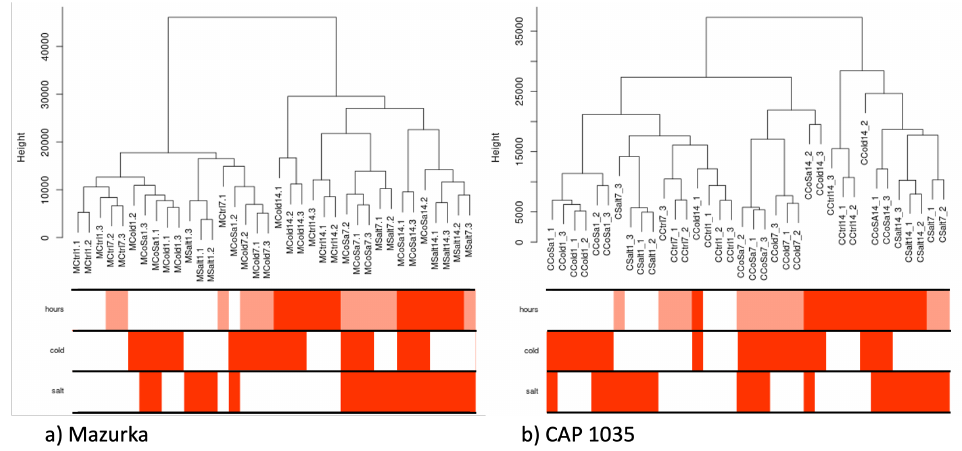
Figure A3. Dendrogram of trait cluster for Mazurka ( a ) and CAP1035 ( b ) from single analysis approaches. RNASeq reads were used to perform a cluster network analysis (see also methods). The dendrogramm shows what clusters will be formed according to the read abundance in combination with the single traits. Traits are indicated as harvest time point (hours), chilling temperature (cold) or salt treatment (salt). Combinatory stresses are indicated as CoSa. The number behind the stress indication reflects first the harvest time point (1, 7 or 14) followed by a number for the single RNASeq sample (1,2 or 3).